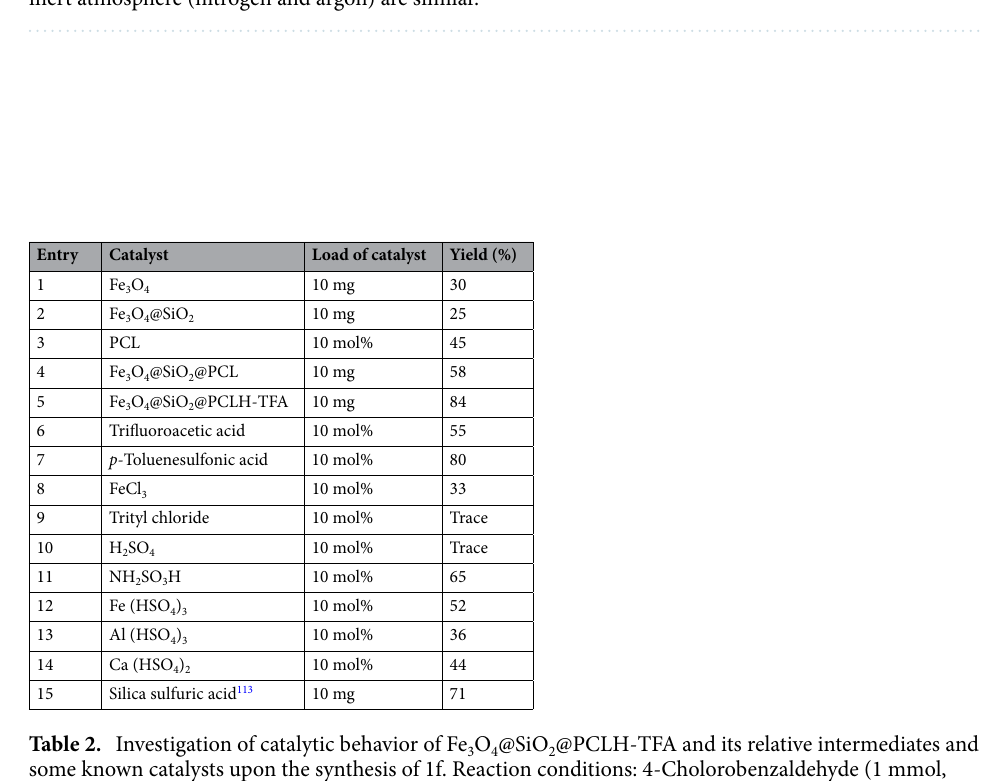
Table 1. Optimizing of the reaction condition for the synthesis of 1f. Reaction conditions: 4-cholorobenzaldehyde (1 mmol, 0.140 g), 4-acetylphenyl-4-methylbenzenesulfonate (2 mmol, 0.580 g), and ammonium acetate (1.5 mmol, 0.115 g). a Related to isolated yields. b Data for the model reaction under air, and inert atmosphere (nitrogen and argon) are similar.